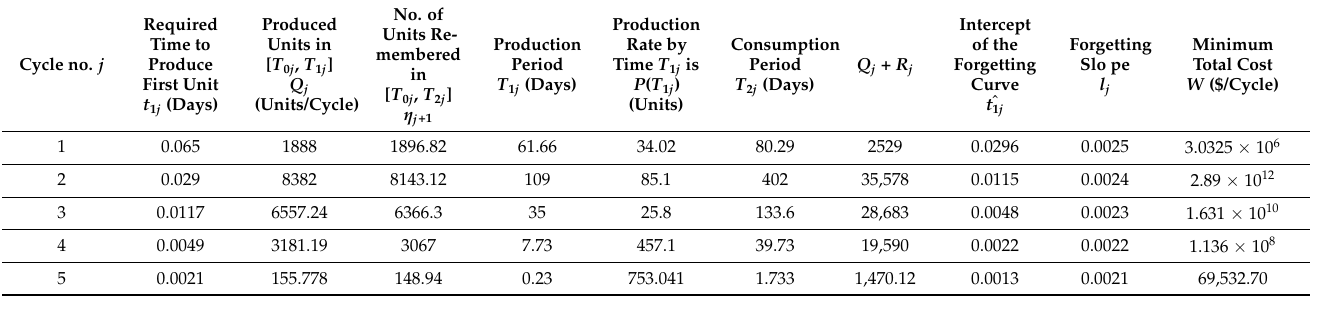
Table 2. Optimal solutions with the partial transmission of learning for Example 1.